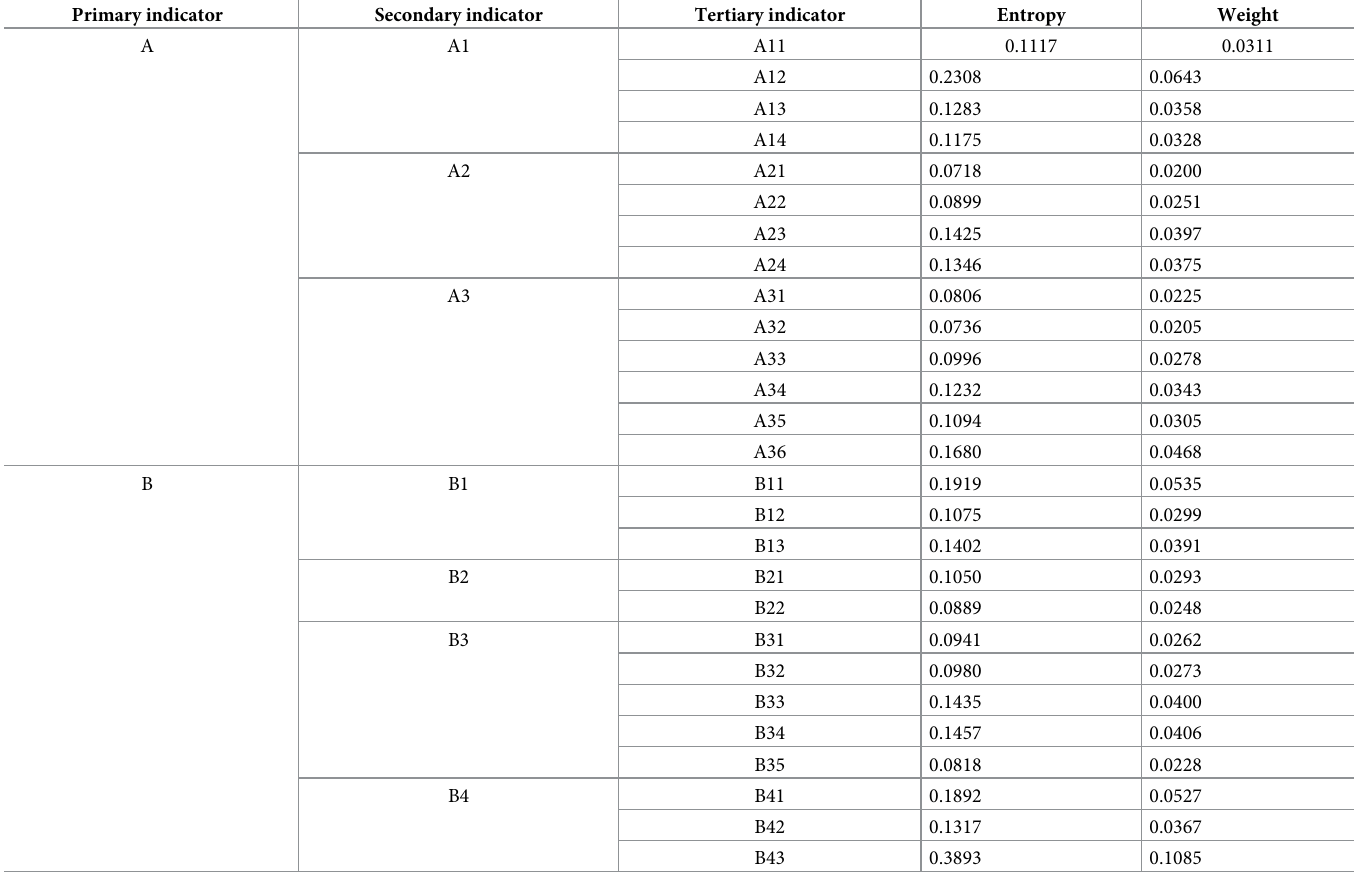
Table 3. Entropy value and weight of indicators in pharmaceutical innovative ecological rainforest in Zhejiang